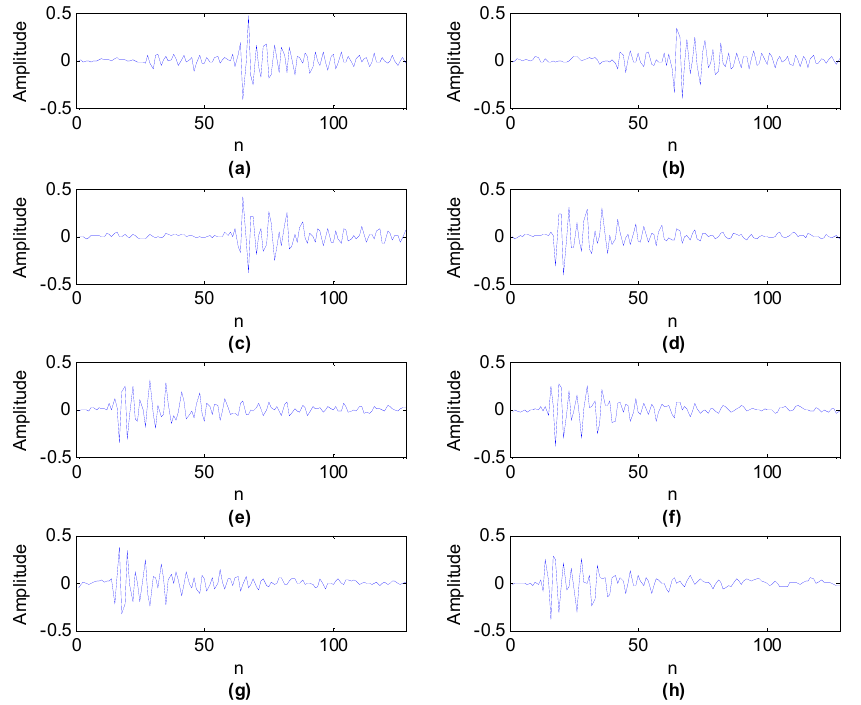
Figure 8. The eight learned basis functions using shift invariant K-SVD algorithm corresponding to outer race and rolling element compound fault.